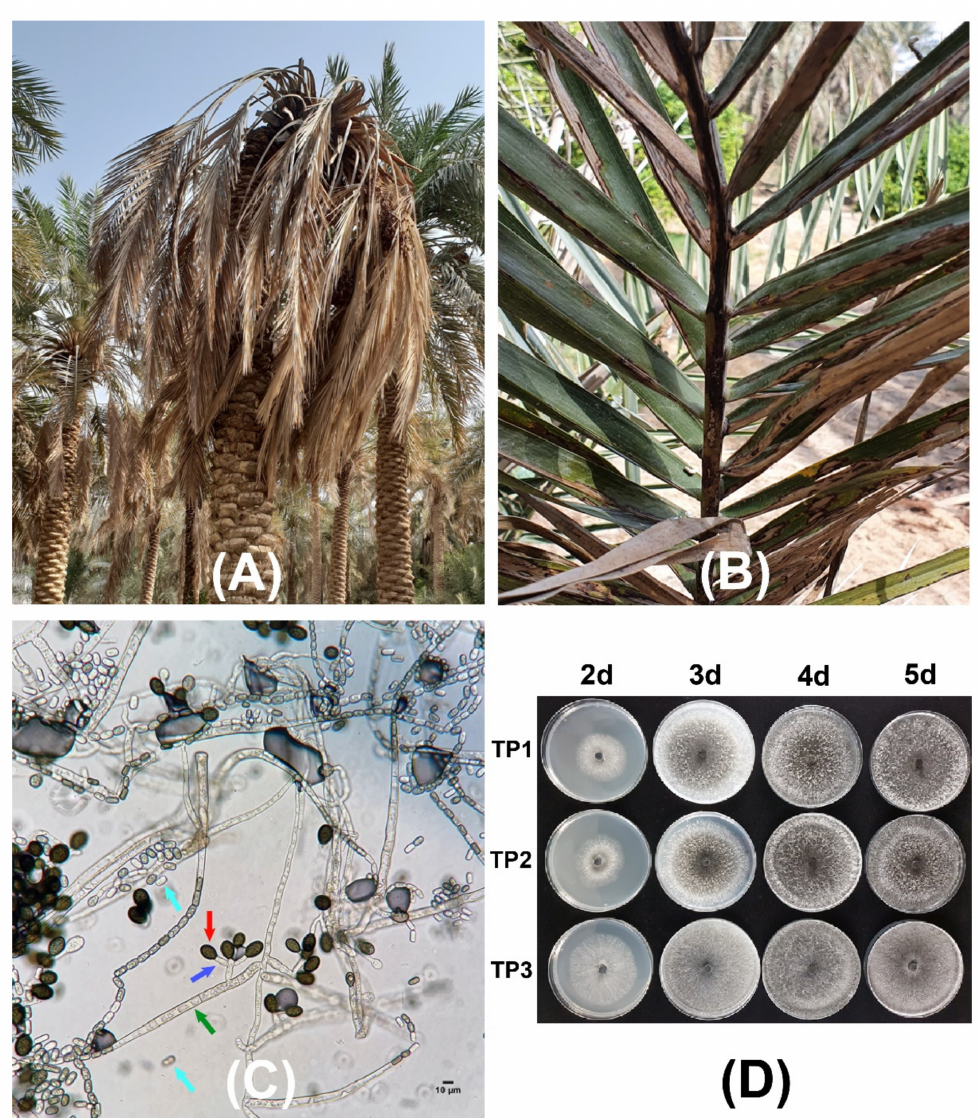
Figure 1. Black scorch disease symptoms and microscopic confirmation of the causal agent Thielaviopsis punctulata . Date palm plants showing neck bending ( A , B ) leaf drying under natural field conditions. ( C ) Mycelial growth of T. punctulata and conidiogenous cells showing aleuroconidia and phialoconidia. The arrows in green, red, blue, and turquoise represent T. punctulata septate hyphae, aleuroconidia, conidiophores, and phialoconidia, respectively. ( D ) Colony morphology of the three T. punctulata isolates (TP1, TP2, and TP3) after 2, 3, 4, and 5 days, at 21 ◦ C on potato dextrose agar (PDA),